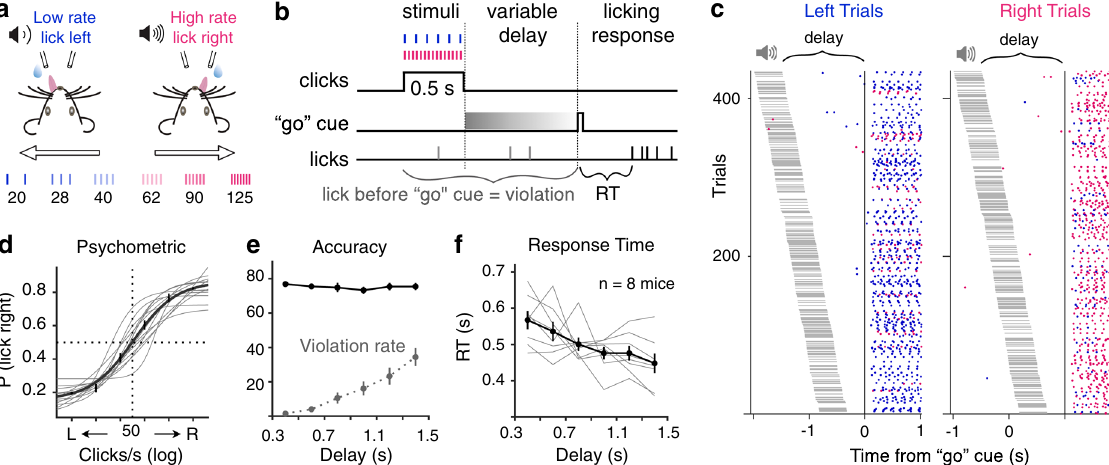
Fig. 1 A memory-guided click rate discrimination task in head- fi xed mice. a Schematic of behavioral paradigm. b Temporal structure of a task trial. A variable delay period sampled from a uniform distribution (0.3 – 1.5 s) is randomly assigned for each trial. Trials with premature licking are marked as violations and excluded from further analyses. For non-violation trials, the response time (RT) is de fi ned as the time between the onset of the “ go ” cue and animals ’ fi rst lick. c Lick raster during an example session. Left licks (blue dots) and right licks (magenta dots) are plotted for left and right trials, aligned to the “ go ” cue, and sorted by delay durations. Timings of the sound are marked by gray horizontal lines. d Sigmoid fi t of psychometric performance. Thick line, mean fi t; thin lines, individual mice ( n = 14); error bars, s.e.m. across all trials. e Accuracy (solid black) and violation rate (dotted gray) as a function of delay duration. Mean and s.e.m. across mice ( n = 8 mice). f Response time (RT) decreases as a function of delay duration. P = 0.004 for shortest vs longest delay duration, two-sided bootstrap test, n = 8 mice. Black thick lines, mean and s.e.m. across mice; gray thin lines, normalized median RTs for individual